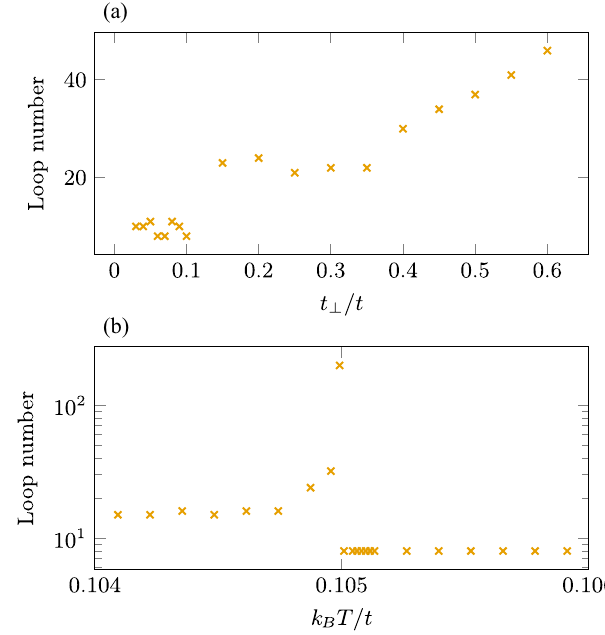
FIG. 5. Number of self-consistent loops required for conver- gence for (a) a ground-state calculation for different values t ⊥ at L ¼ 100 , n ¼ 0 . 5 , U ¼ − 4 t , χ ¼ 300 , and MF term range r ¼ 4 , and (b) a finite-temperature calculation for different temperatures at L ¼ 60 , n ¼ 0 . 5 , U ¼ − 10 t , t ⊥ ¼ 0 . 3 t , χ ¼ 200 , and MF terms with range r ¼ 1